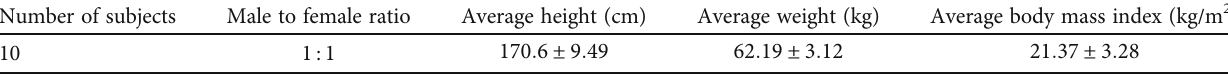
Table 1: Subject information in the Myo_data